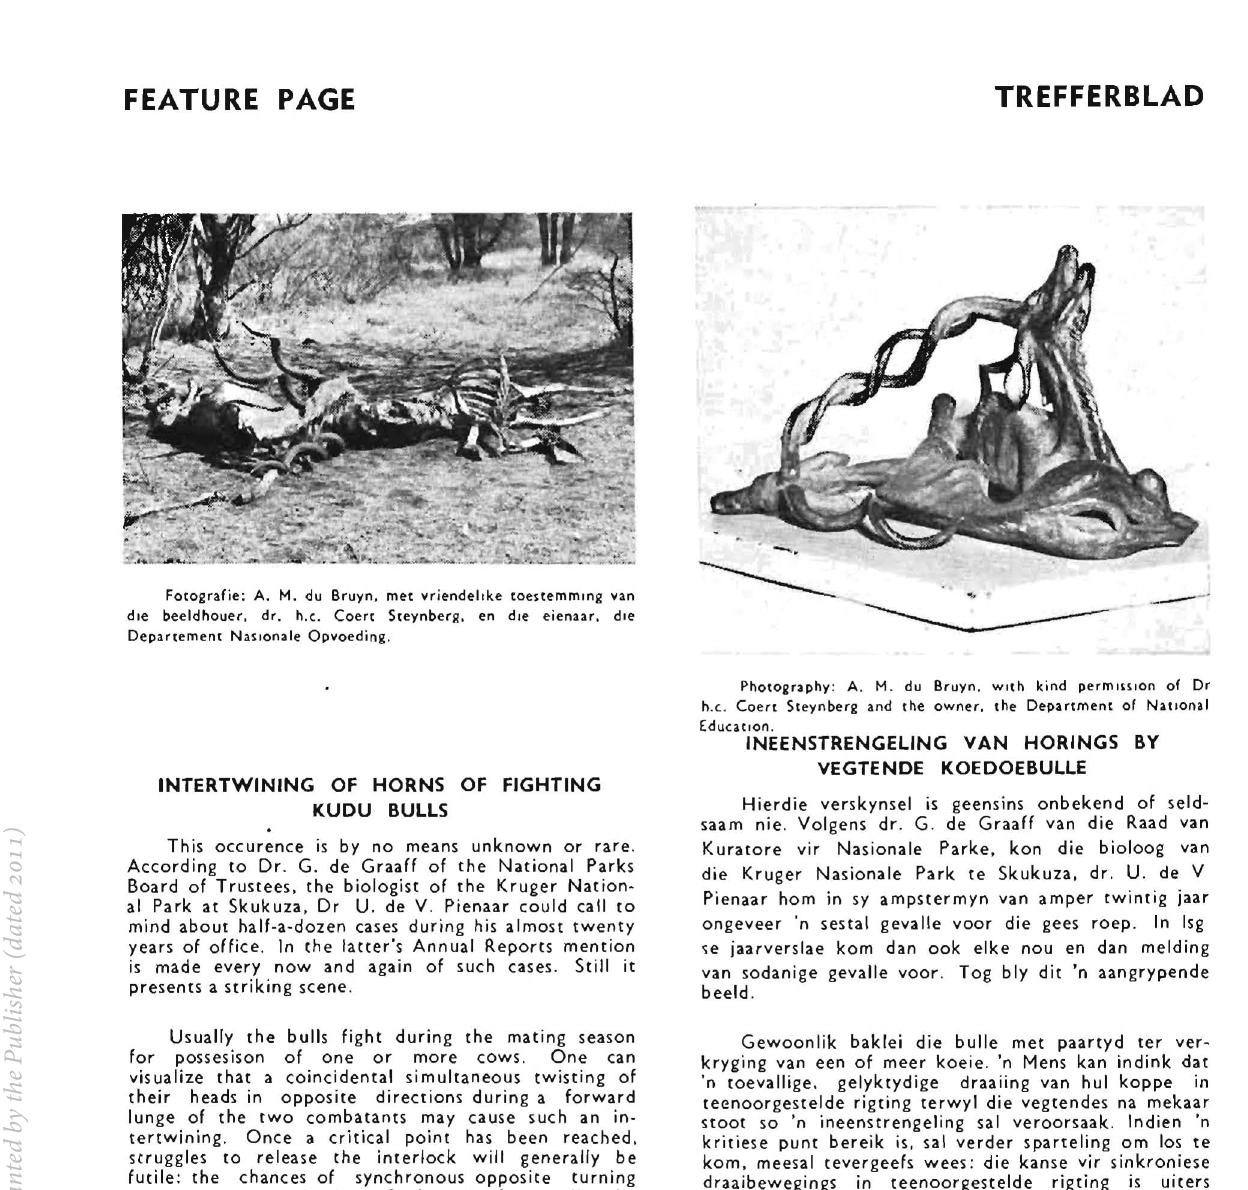
Fotografie: A. M. du Bruyn, met vriendeltke toestemmmg van die beeldhouer, dr. h.c. Coert Steynberg, en dIe eienaar, die Depar'tement Naslonale